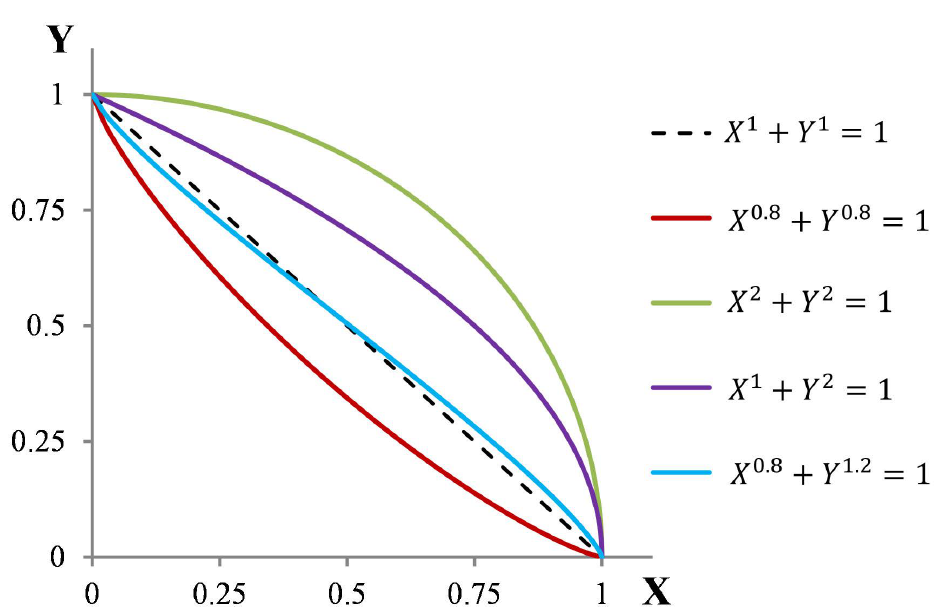
Figure 48. Influence of the exponents on the shape of the interaction